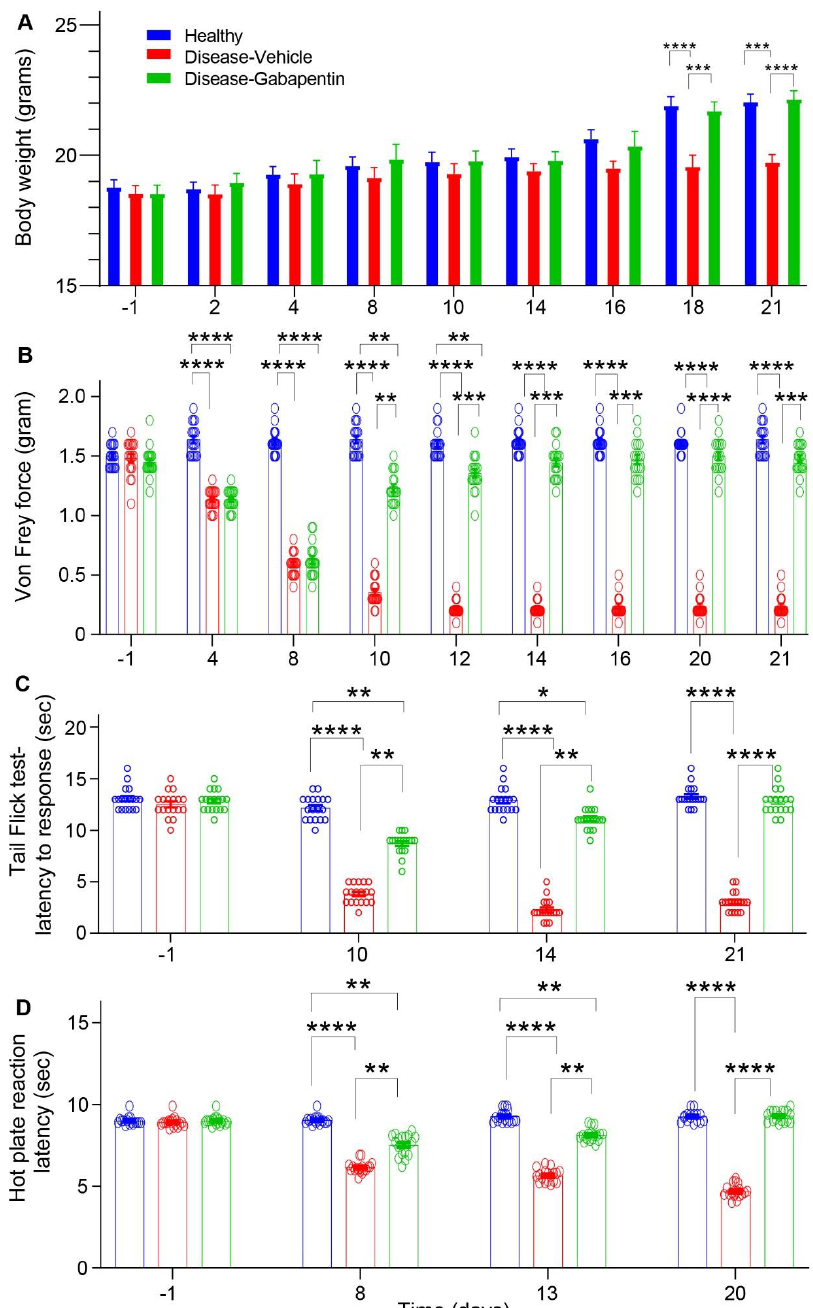
Figure 2. The inhibitory effects of gabapentin on the body weight and on Taxol-induced mechanical and thermal allodynia in mice. ( A ) Taxol-treated mice (disease-vehicle) gained less weight than controls (healthy) from day 18–21, but their weight normalized in gabapentin-treated mice (disease-gabapentin). ( B ) Taxol-induced hypersensitive response to von Frey filament stimulations test (disease-vehicle) com- pared to control (healthy). Taxol-induced mechanical allodynia was significantly improved during two weeks of gabapentin treatment (disease-gabapentin). ( C ) Tail-flick test latency to response was significantly decreased in Taxol-treated mice (disease-vehicle) compared to control (healthy), but it was normalized in gabapentin-treated mice (disease-gabapentin). ( D ) The reaction latency times measured using the hot plate thermal hyperalgesia test were significantly decreased in Taxol-treated mice (disease-vehicle) compared to control (healthy), but they were normalized in gabapentin-treated mice (disease-gabapentin). The results are means ± SEM (n = 18); The level of significance (*) assumed was 1% (** p ≤ 0.01); 0.1% (*** p ≤ 0.001); 0.01% (**** p ≤ 0.0001); one-way ANOVA, followed by Dunn’s